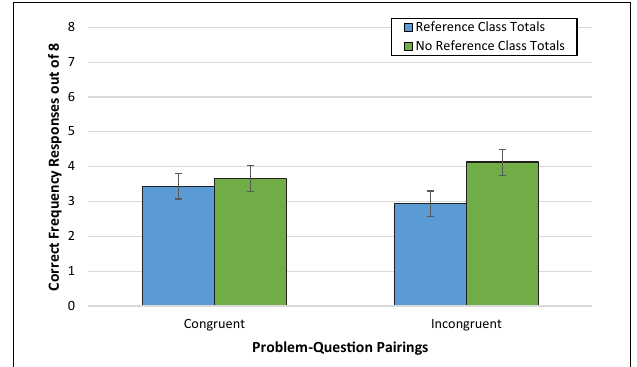
FIGURE 3 | Experiment 1b condition accuracy means while controlling for numeracy. Error bars represent ± 1 SE.